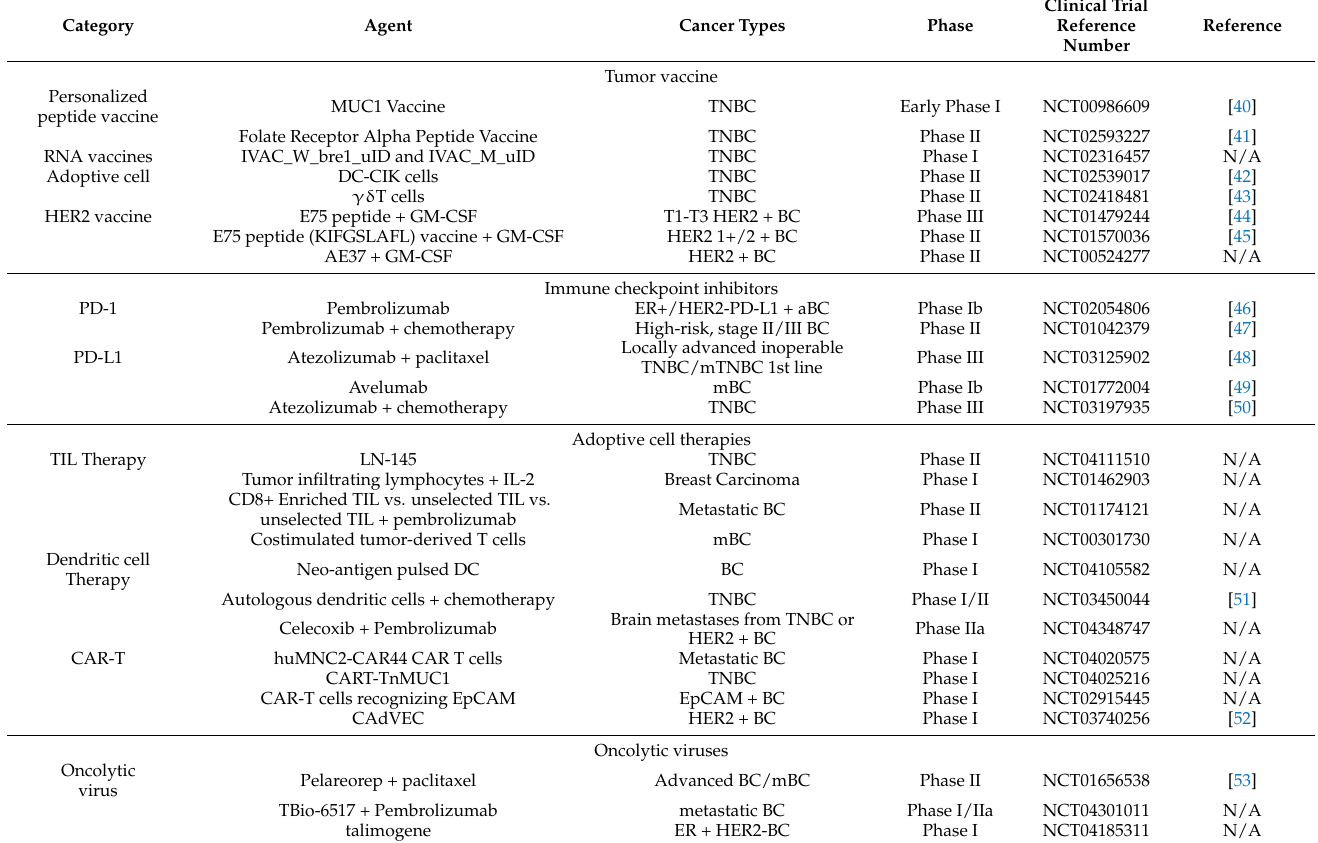
Table 1. Breast cancer immunotherapeutic drugs in clinical use or